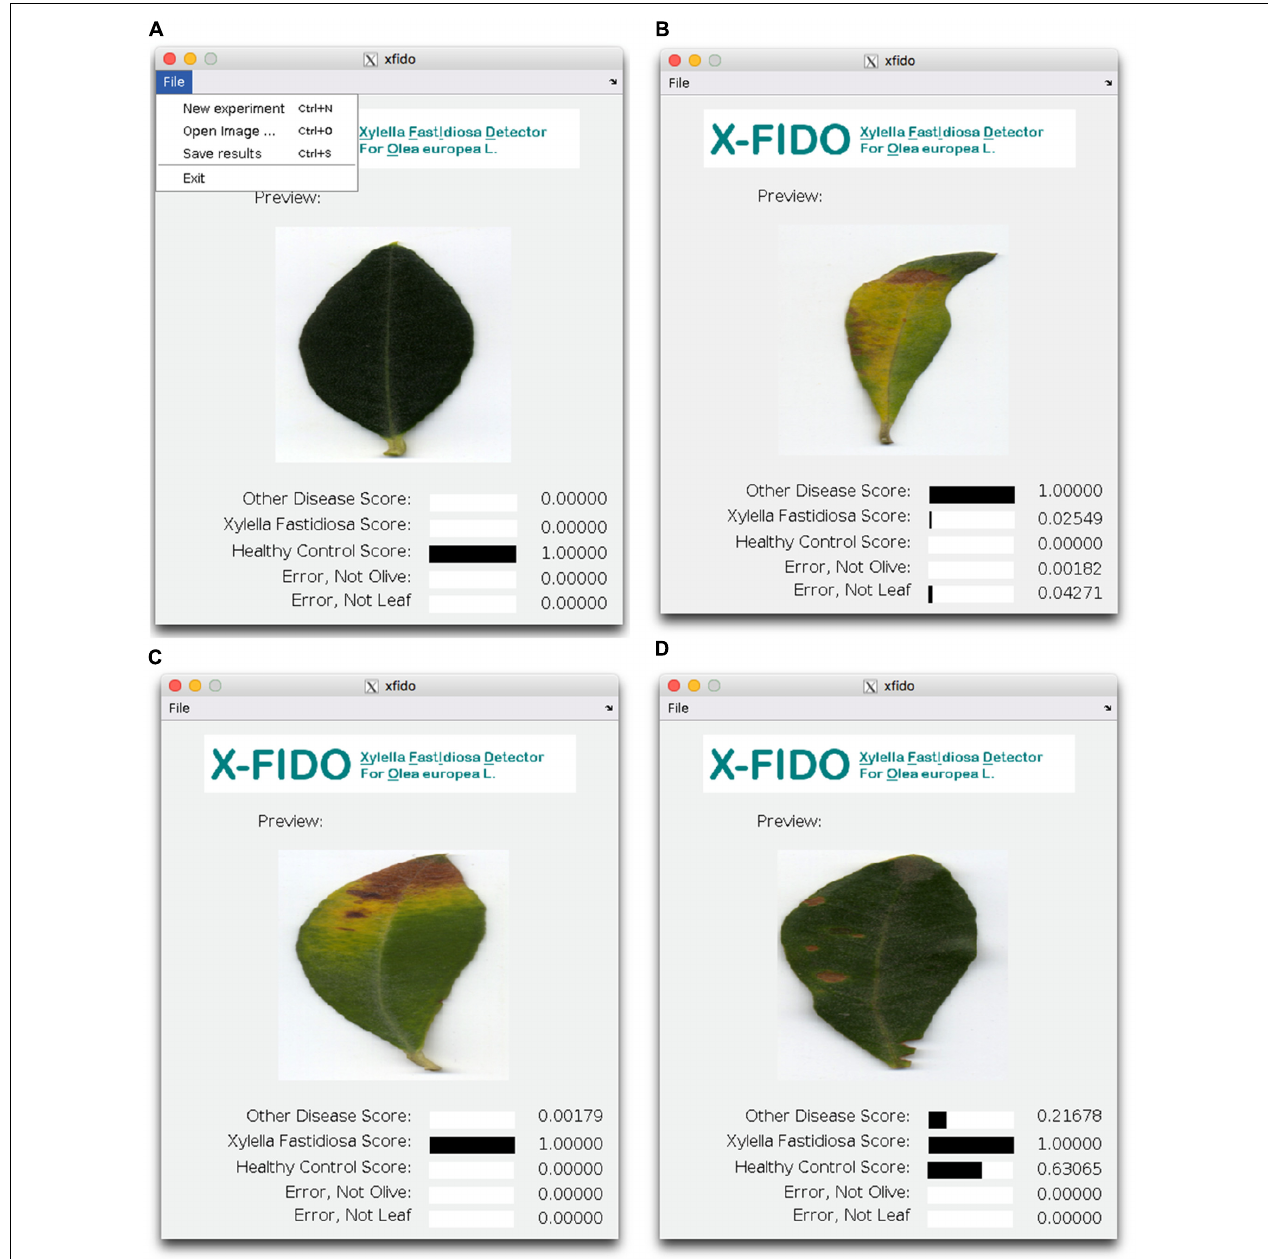
FIGURE 8 | Screen shots of the X-FIDO program. (A) The program is simple to operate and consists of three commands: New experiment; Open image, which prompts the user to open an image, automatically processes the image and logs the confidence scores; and Save results, which saves all logged confidence scores to a comma-separated value (CSV) file. In this sub-figure, the program correctly classified a healthy control. (B) A non-OQDS pathogen/disorder. (C) OQDS ( X. Fastidiosa ). (D) A very challenging sample of a non-OQDS image that resembles OQDS because of very faint leaf tip desiccation, and a healthy control because of